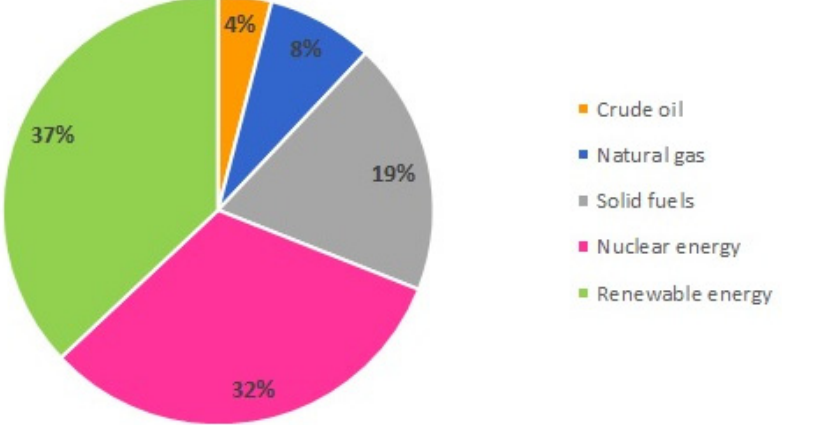
Figure 1. Share of EU energy production by source, 2019 (source: [4]).